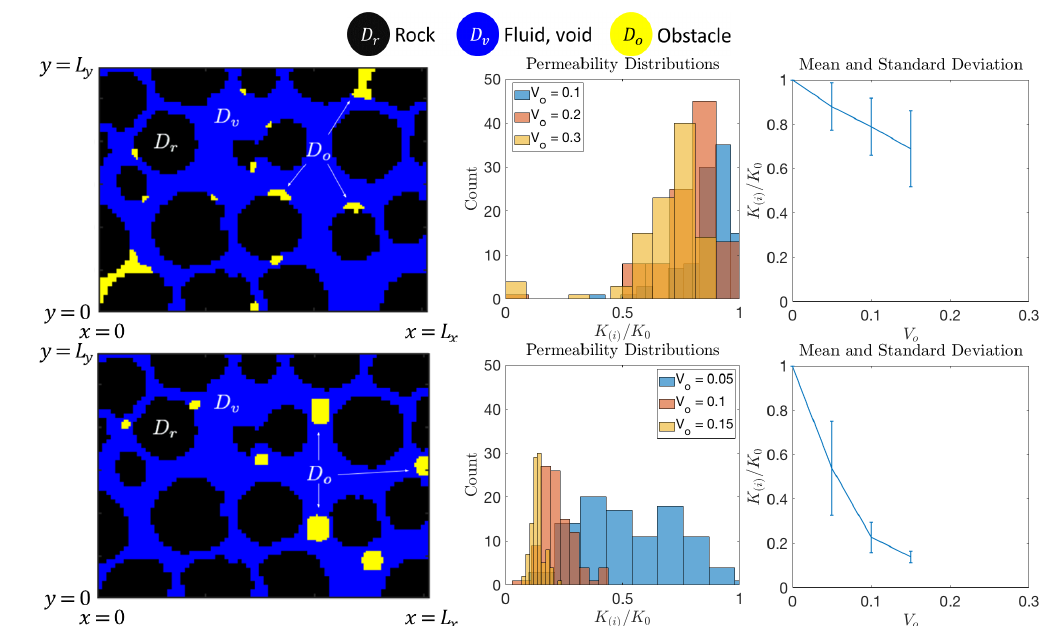
Figure 26. Flow properties with geometries D o created by CLPS in Example 4. Top row: pore-coating, and bottom row: pore-filling geometries. Left: example of D o with V o = 0.05. Middle and right: experimental probability distribution of relative change in permeability K ( i ) / K 0 ) i for three values of V o .